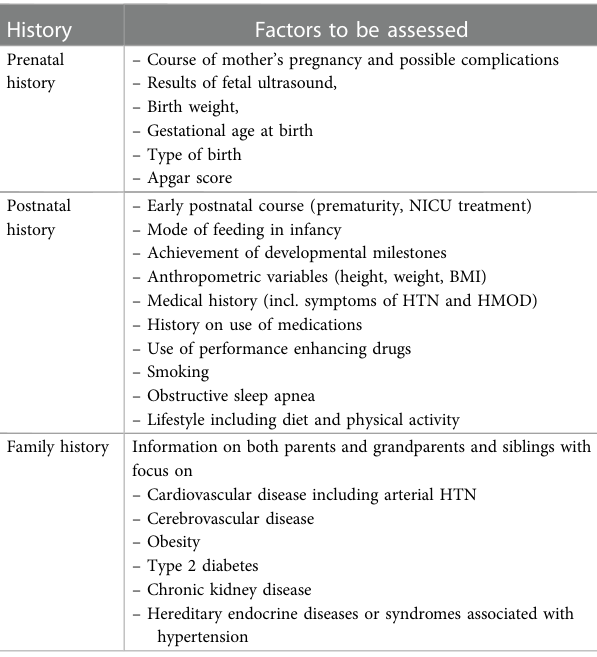
TABLE 1 Assessment of patient and family history for hypertension and cardiovascular risk